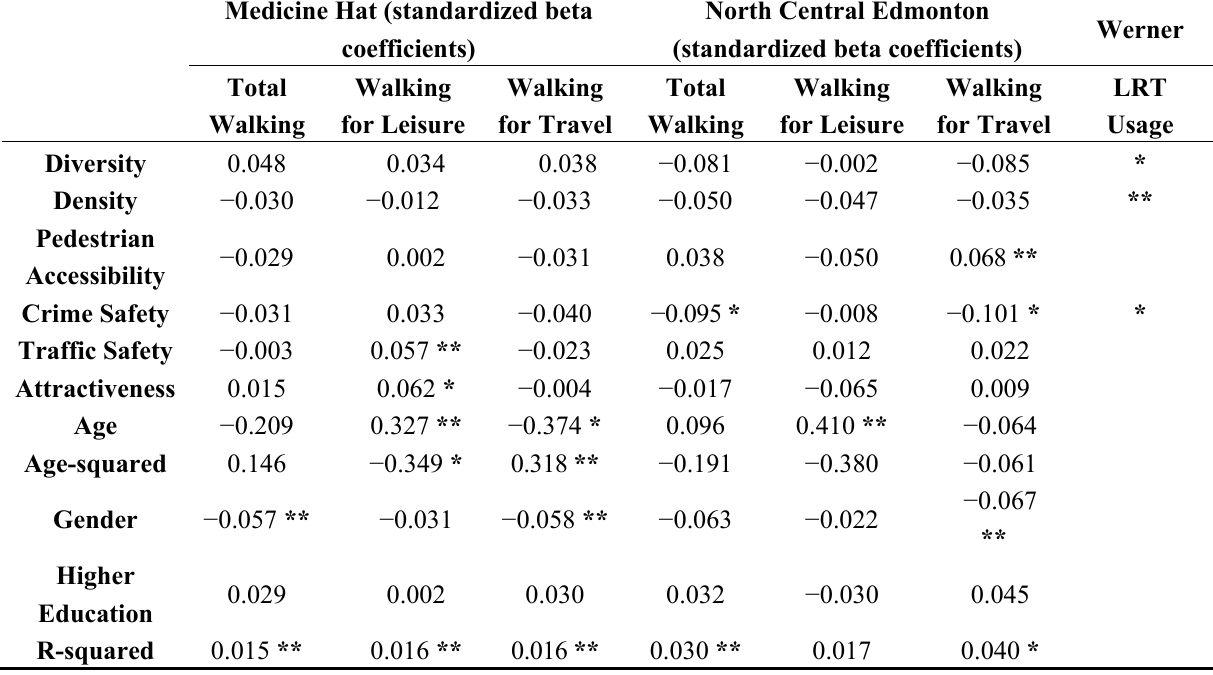
Table 6. Regression analysis of built environment scales and walking behaviors in Werner and CHBE